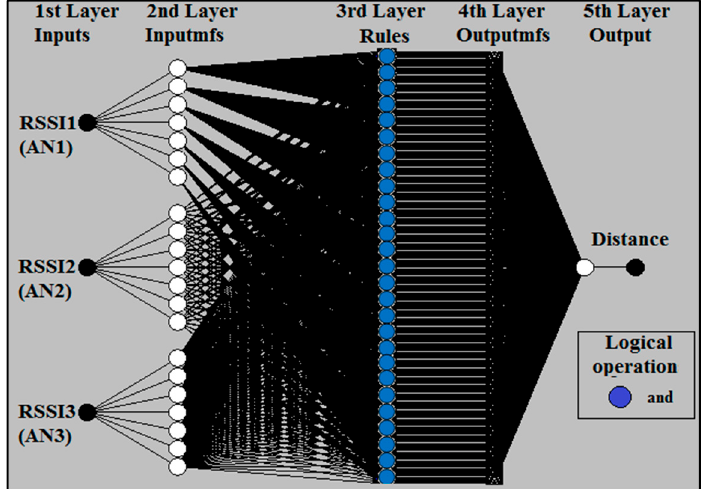
Figure 7. The adopted ANFIS structure for seven gbellmfs .